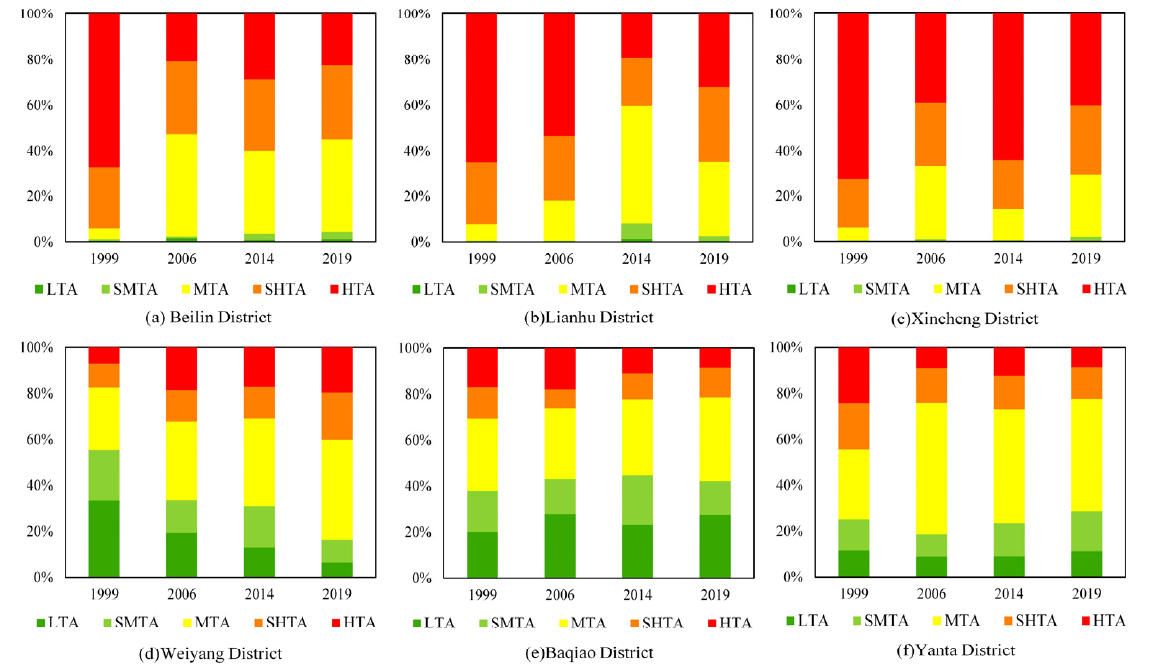
Figure 3. Area proportion of LST for four periods in six districts of Xi’an.